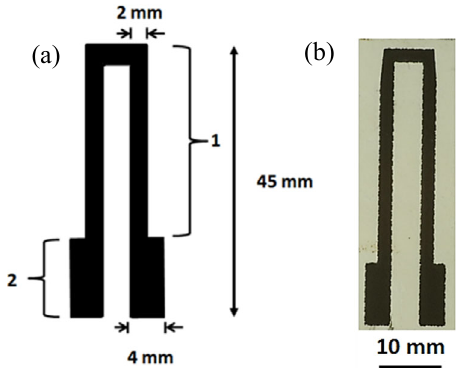
Fig. 1 (a) Printing design and (b) screen-printed P2.2